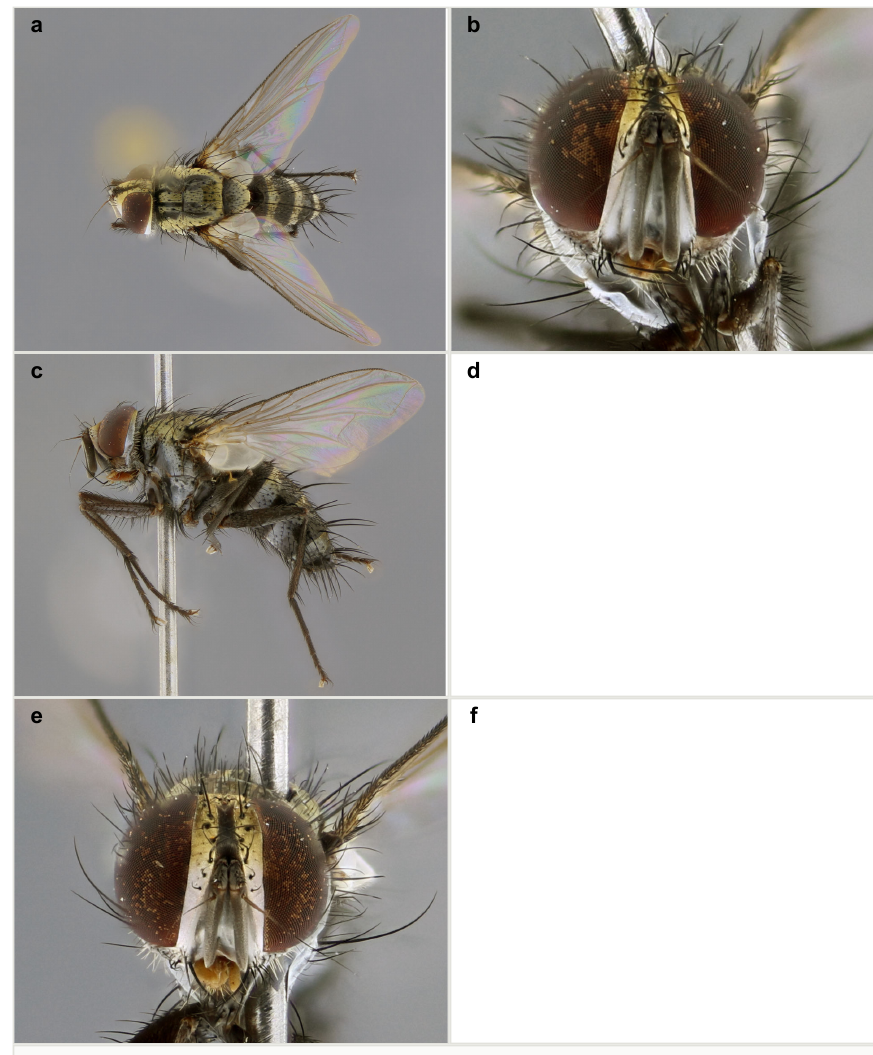
General morphology of Calolydella felipechavarriai sp. n. ; a–c : male holotype, voucher